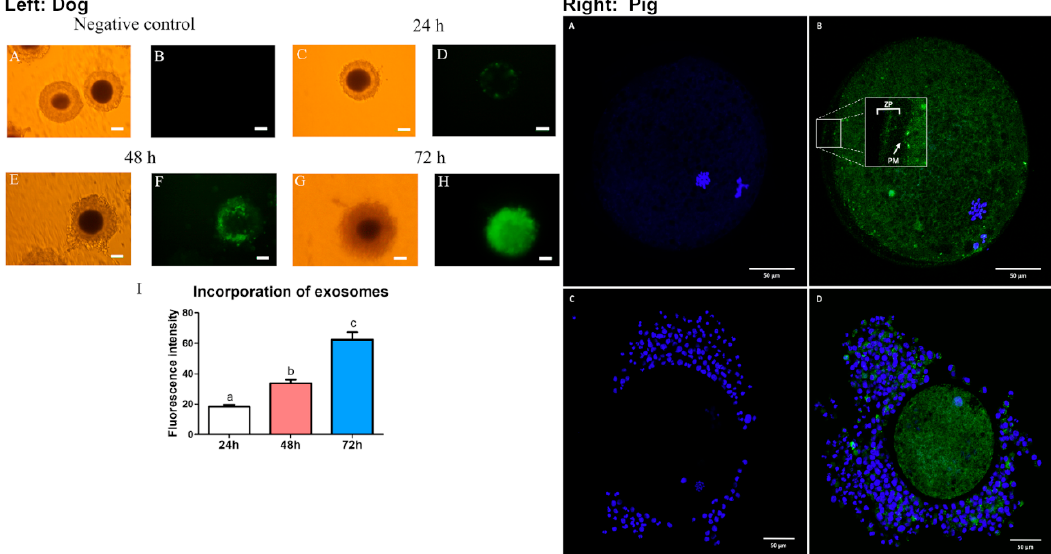
Figure 2. EVs from the oviduct are transferred to the oocytes in dogs (left panel) and pigs (right panel). ( Left ) Canine oEV incorporation in the canine cumulus-oocyte increases over time. ( A , B ) negative control, ( C , D ) 24 h, ( E , F ) 48 h, and ( G , H ) 72 h after incubation with (PKH67)-labeled canine oEVs. ( I ) Incorporation of exosomes as measured by fluorescent intensity over time. Bright field images ( A , C , E , G ), green fluorescent (PKH67) images ( B , D , F , H ). Length of scale bars was not indicated in the original study. Reprint with permission from [58]. ( Right ) Images of oocytes from pigs after 20 h of incubation in the presence of ( A , C ) negative control or ( B , D ) 0.4 µg/µL of green florescent (PKH67)-labelled porcine oEVs. ( A , B ) porcine denuded mature oocytes. ( C , D ) cumulus-oocyte complex. ZP; zona pellucida, PM; plasma membrane, blue; Hoechst staining, green; PKH67-EVs staining. Scale bars; 50 µm. Reprint with permission from [59].